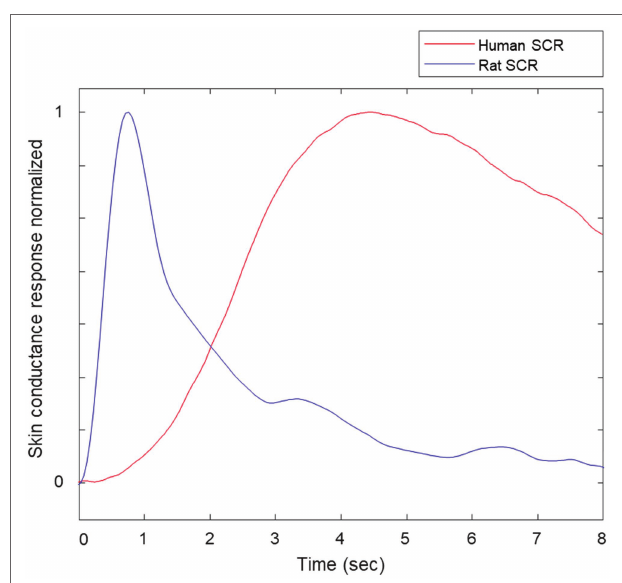
FIGURE 4 | Samples of normalized skin conductance responses (SCRs) of human and